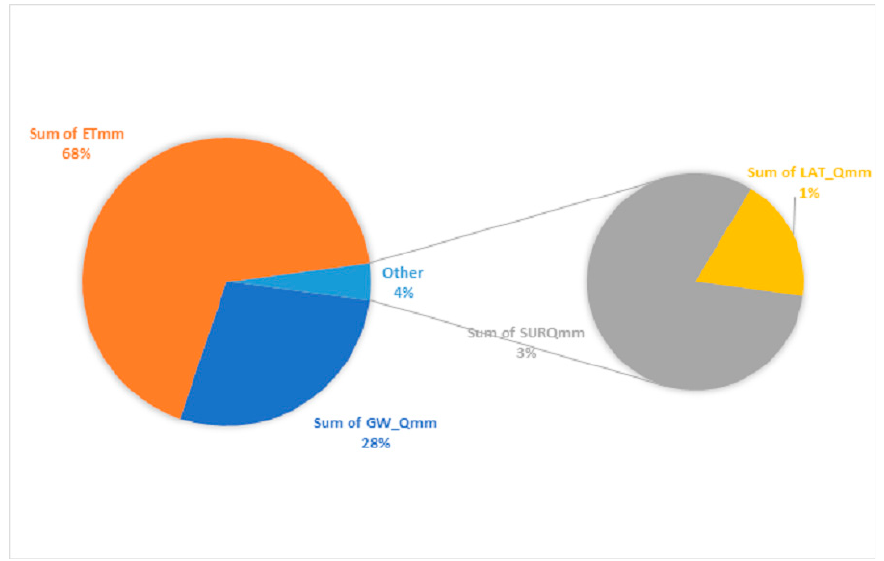
Figure 6. Pie-diagram showing the quantification of the basin hydrological processes (except precipitation). Note that evaporation and transpiration (Sum of ETmm) have the highest share of 812.9 mm (68%) of the water balance, while lateral flow (Sum of Lat_Qmm) has 9.76 (1%) of the total rainfall. Total aquifer recharge (Sum of GW_Qmm) is 340.15 (28%) and runoff (Sum of SUR_Qmm) constitute 40.91 mm (3%) of total rainfall.